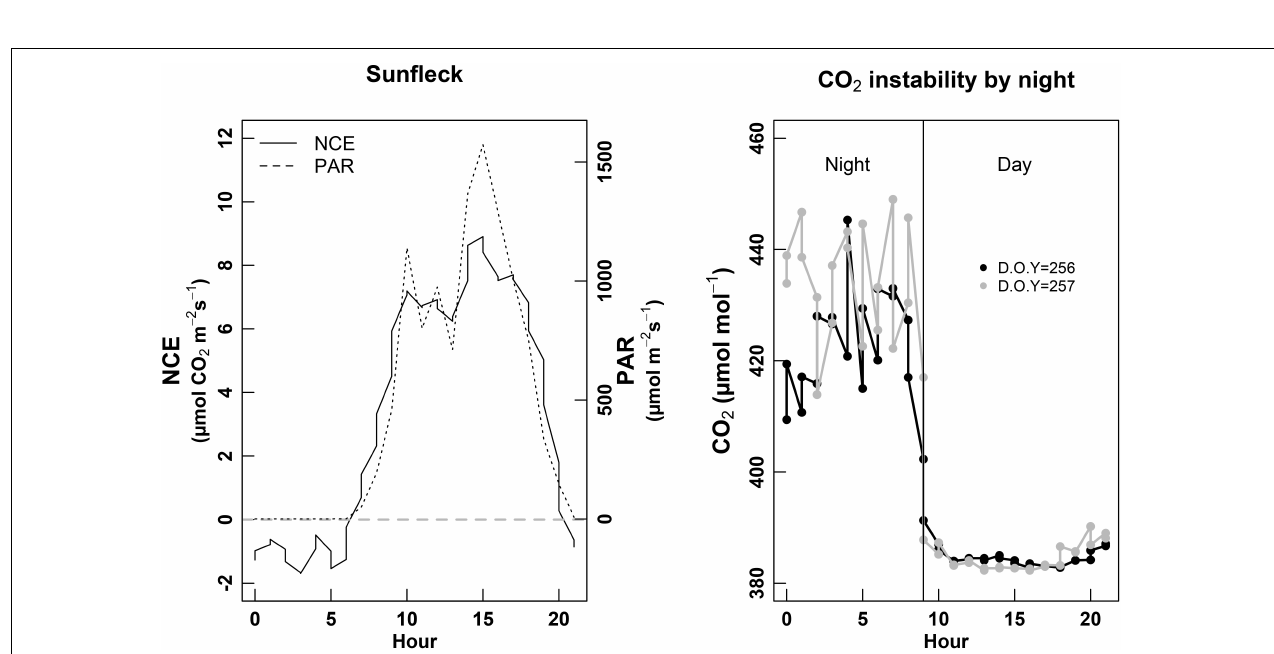
FIGURE 3 | Left panel: example of sun fleck (PAR, discontinuous line) effect on the NCE (net carbon exchange of the whole-plant, continuous line). Right panel: monitoring of the [CO 2 ] entering the chamber (atmospheric [CO 2 ]) over a complete 24 h cycle, during two consecutive days (D.O.Y. 256 black line and D.O.Y. 257 gray line). The vertical continuous black line denotes the day/night